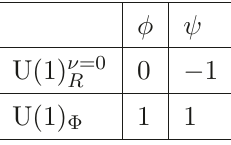
Table 1 . U(1) R U(1) Φ symmetry of the free chiral theory. φ and ψ are the complex scalar and × the fermion field inside the = 2 chiral multiplet N